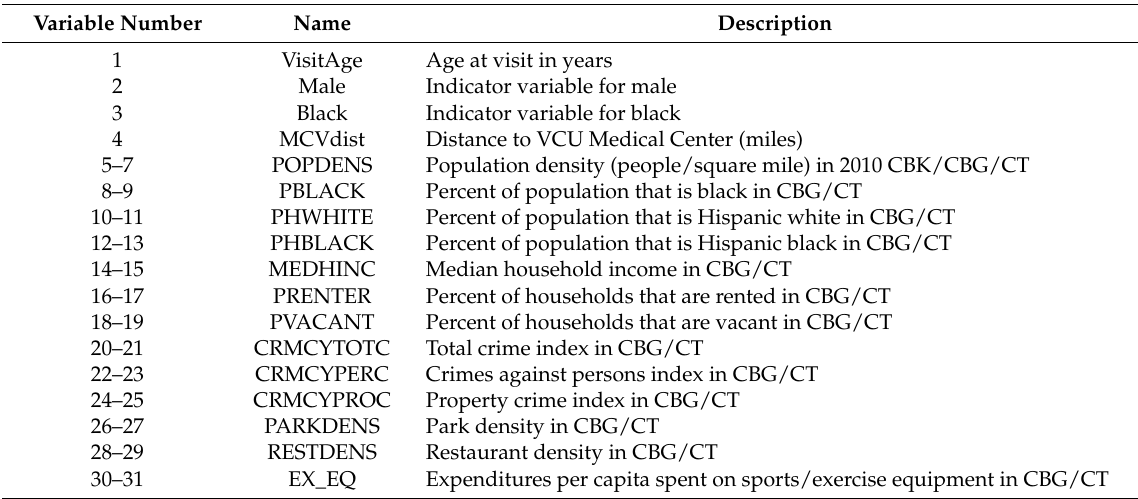
Table 1. Variables available for spatial scale selection algorithms. The horizontal dashed line separates the individual-level variables and the neighborhood-level variables available at more than one spatial scale. CBG: census block group, CBK: census block, CT: census tract, VCU: Virginia Commonwealth University.